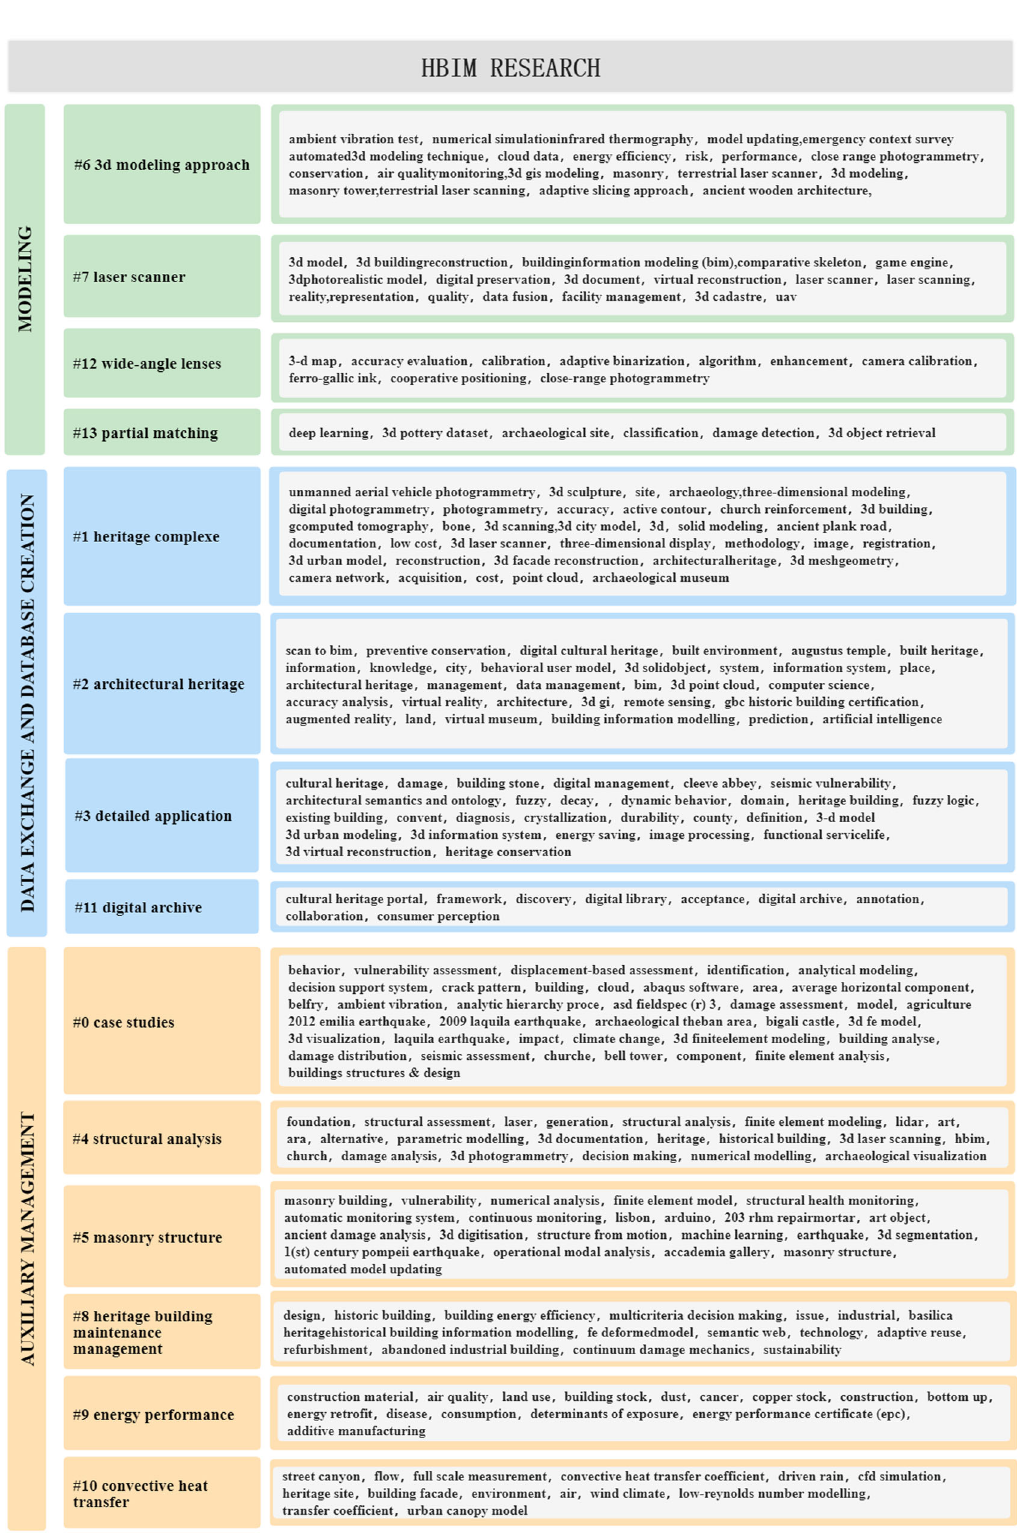
Fig. 13 Hierarchy of keyword clustering. Hierarchy in keyword clustering obtained after analysis of HBIM